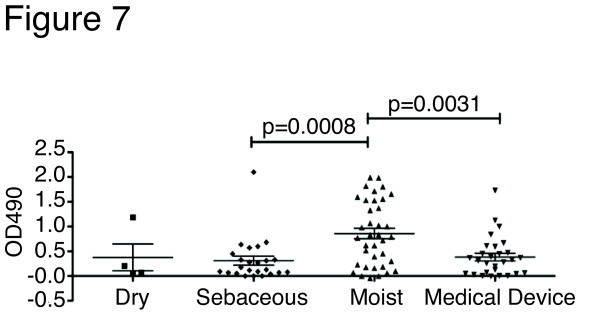
in vitro biofilm formation is associated with isolation source. in vitro biofilm formation on polystyrene surface of 71 commensal and 28 medical device (nosocomial) S. epidermidis isolates. Commensal isolates are subdivided by the skin type (dry, sebaceous and moist) as defined in Grice et al. [24]. Each point represents the average of four replicates. Statistical significance was calculated using Mann-Whitney, two-tailed.